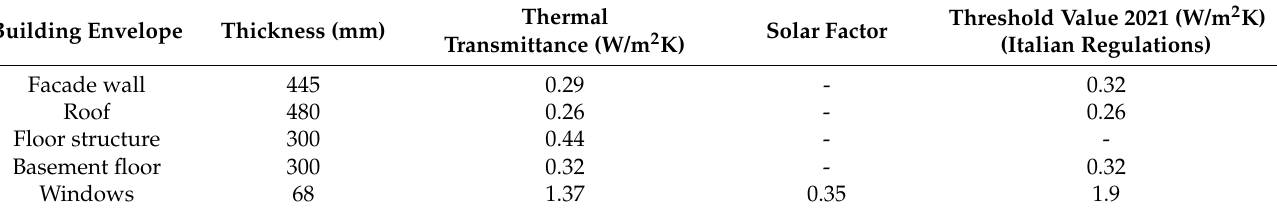
Table 3. Characteristics of the buildings’ thermal envelope in the BIM model.